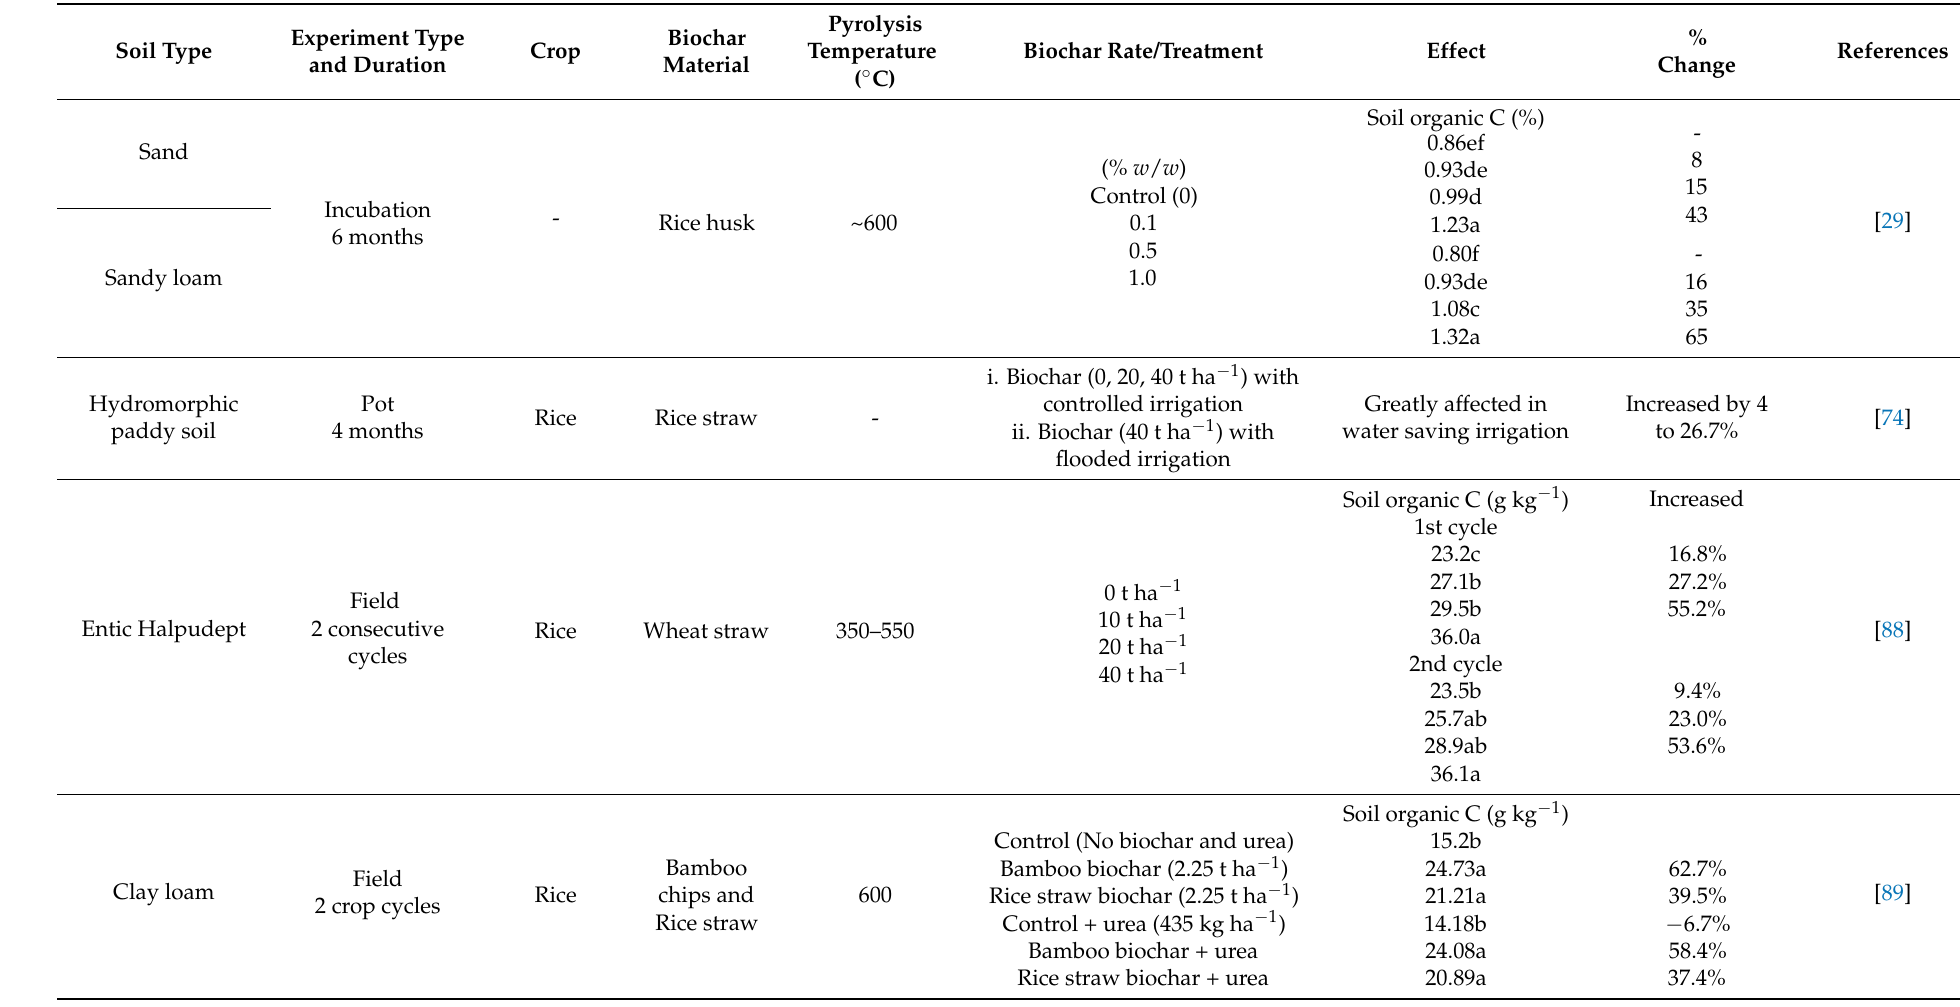
Table 2. Effect of biochar addition on soil carbon © enhancement of different types of soil (different letters in the same column indicating significant difference among the biochar treatment).